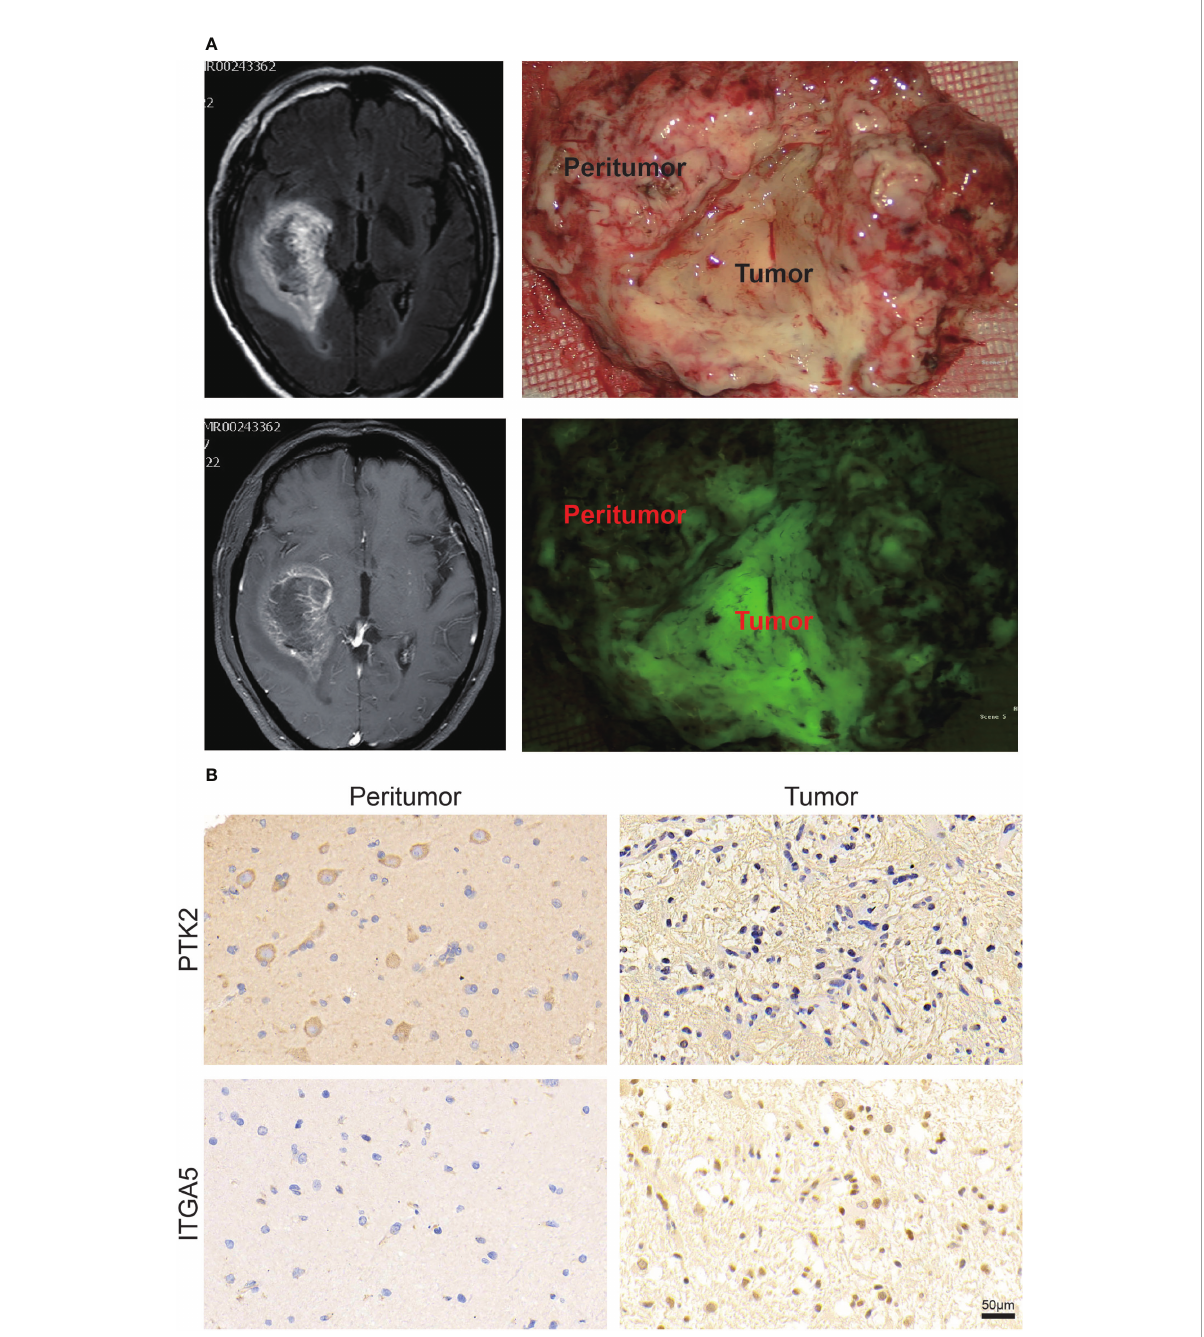
FIGURE 2 Validation of PTK2 and ITGA5 expression in clinical tumor tissues. (A) Representative images of speci fi c clinical specimens of tumor and peritumor tissue. Tumor fl uorescence was used to preliminarily identify the tumor. (B) Representative images of IHC staining for PTK2 and ITGA5 in tumor and peritumor tissue (scale bar: 50 m